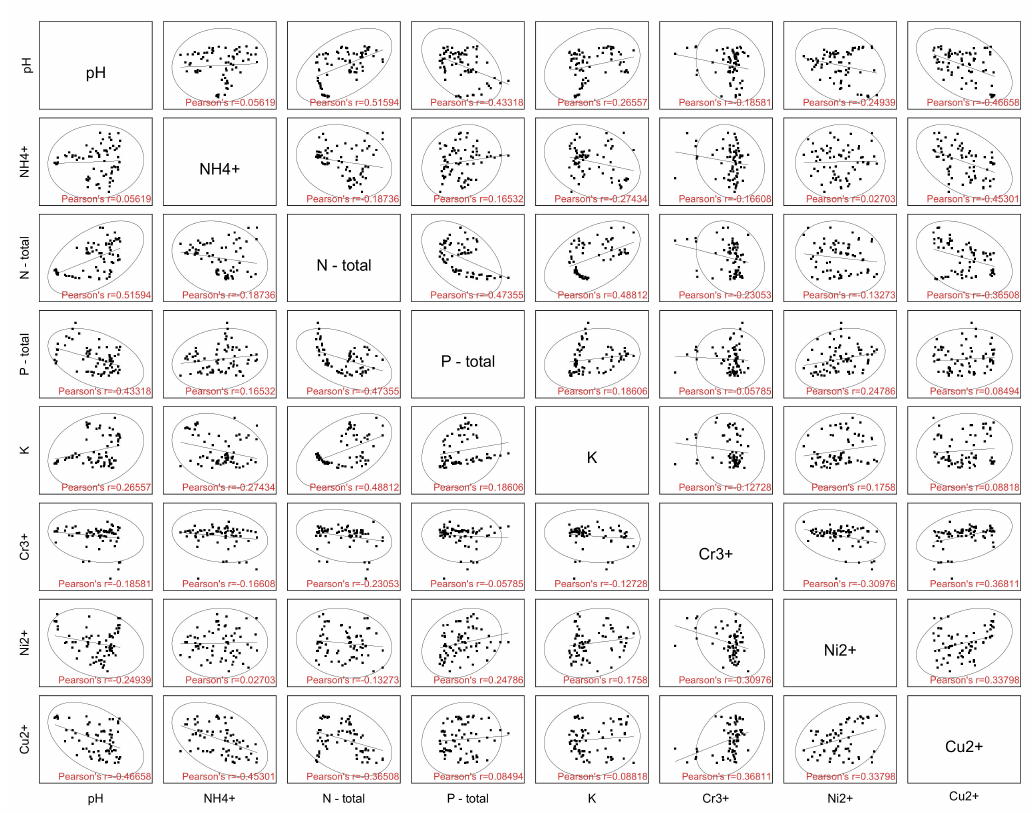
Figure 7. The matrix results of the statistical analysis which show the relationship between nutrients and heavy